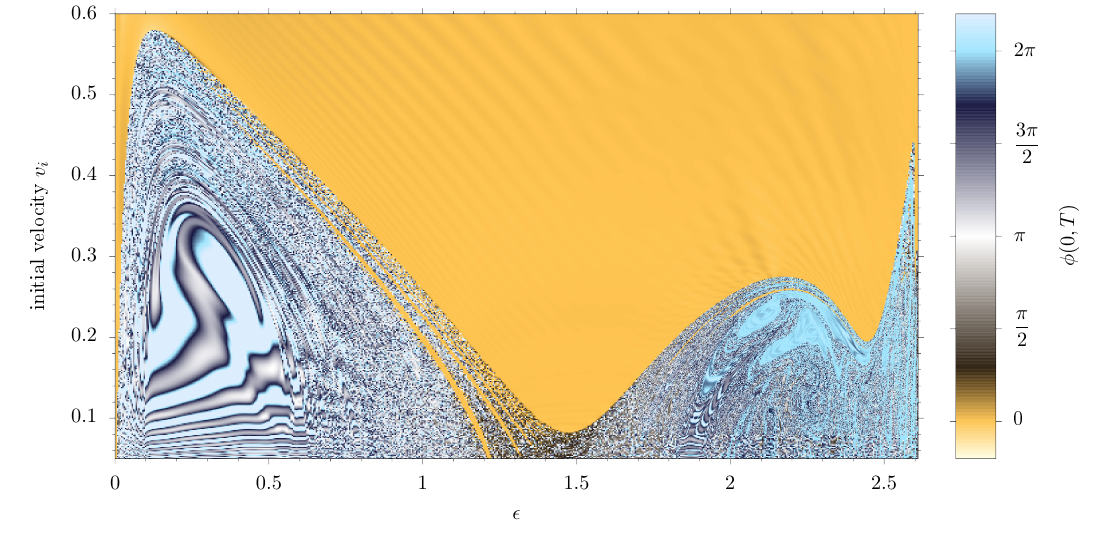
Figure 7 . The post-collision value of the field at the collision centre as a function of the initial velocity of the colliding kinks and the deformation parameter (cid:15) . The field value was measured 300 units of time after the intersection of the initial trajectories, that is 300 + x 0 /v i units of time after the start of the simulation. Figures 20 and 21 below zoom in on the right-hand edge of this